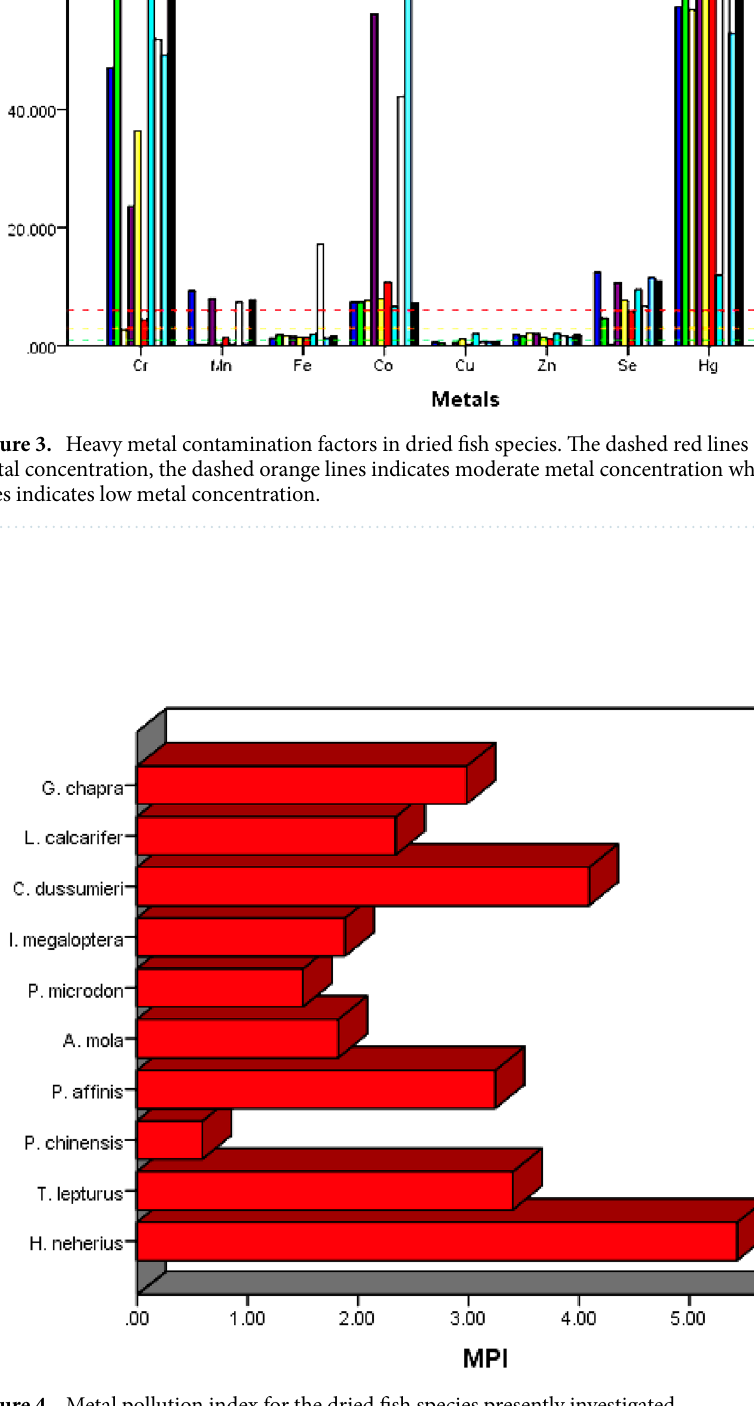
Figure 4. Metal pollution index for the dried fish species presently